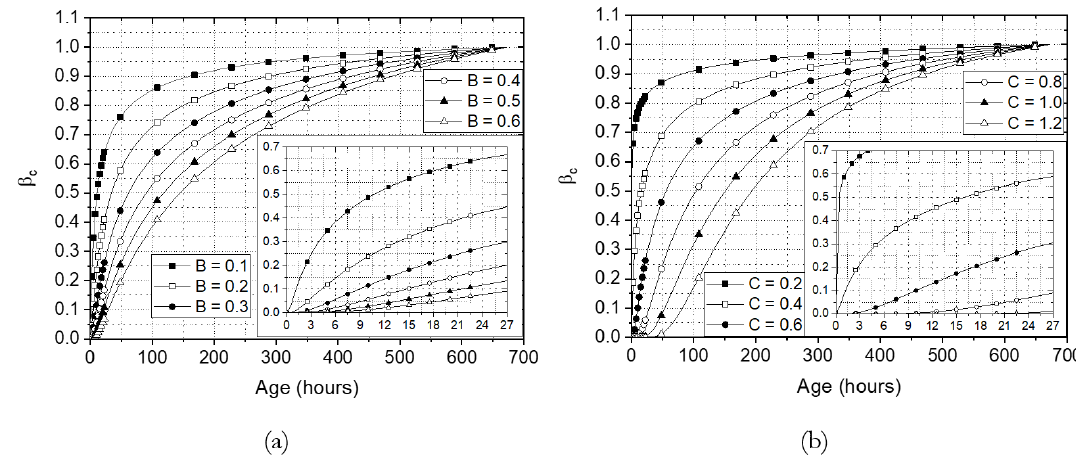
Figure 7 – Variation in coefficient β c with the constants: (a) B variable and C = 0.5 and (b) C variable and B = 0.2.